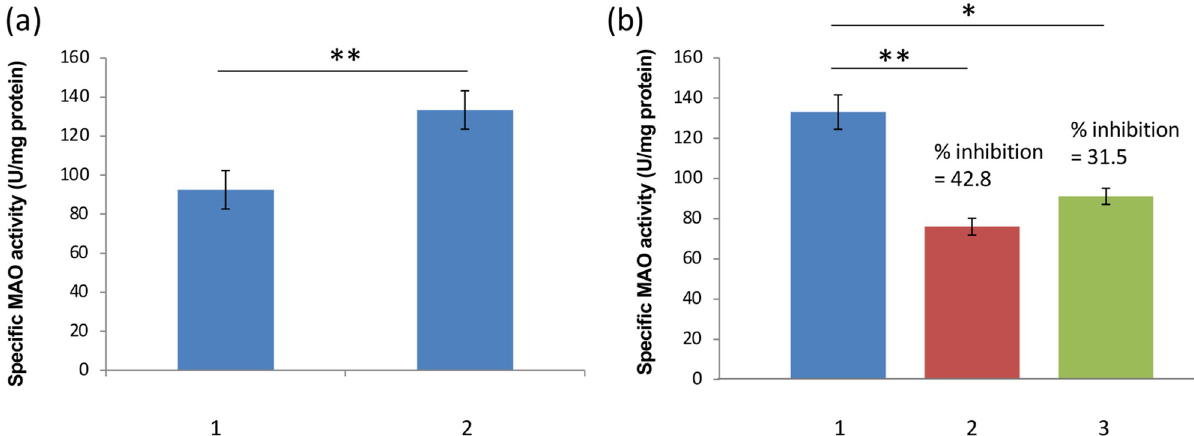
Fig 2. (a) The level of Monoamine Oxidase (MAO) activity of F . gigantica in the whole homogenate (1) and the mitochondrial isolate (2). Since MAOs are present on the outer mitochondrial membrane the enzyme activity was found to be significantly higher (about 1.5-fold increase) in the mitochondrial fraction as compared to the homogenate. The specific enzyme activity was expressed as μ moles Tyramine utilized/mg protein/30minutes at 37˚C. (b) The specific enzyme activity of Monoamine Oxidase (MAO) in the mitochondrial isolate of F . gigantica . 1: F . gigantica control group devoid of any inhibitor. 2: F . gigantica mitochondrial isolate treated with clorgyline. 3: F . gigantica mitochondrial isolate treated with deprenyl. There was a significant decrease in enzyme activity as compared to control when selective inhibitors of MAO were used separately. A minimum of 3 replicates were run and the data is expressed as a mean ± SEM.